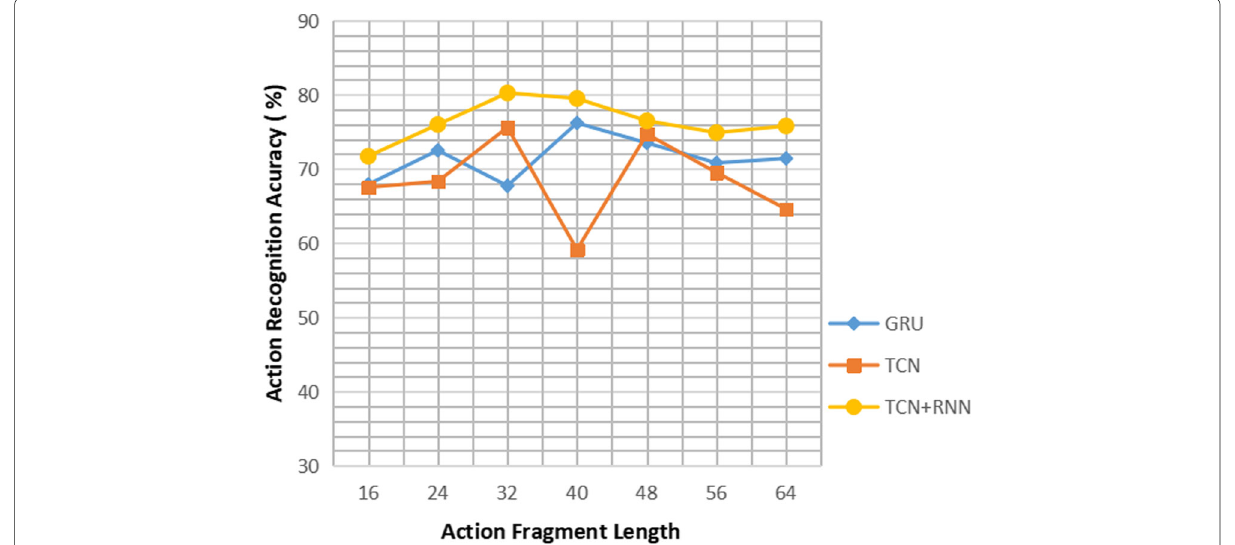
Fig. 9 The recognition accuracy of action segments with different lengths in different